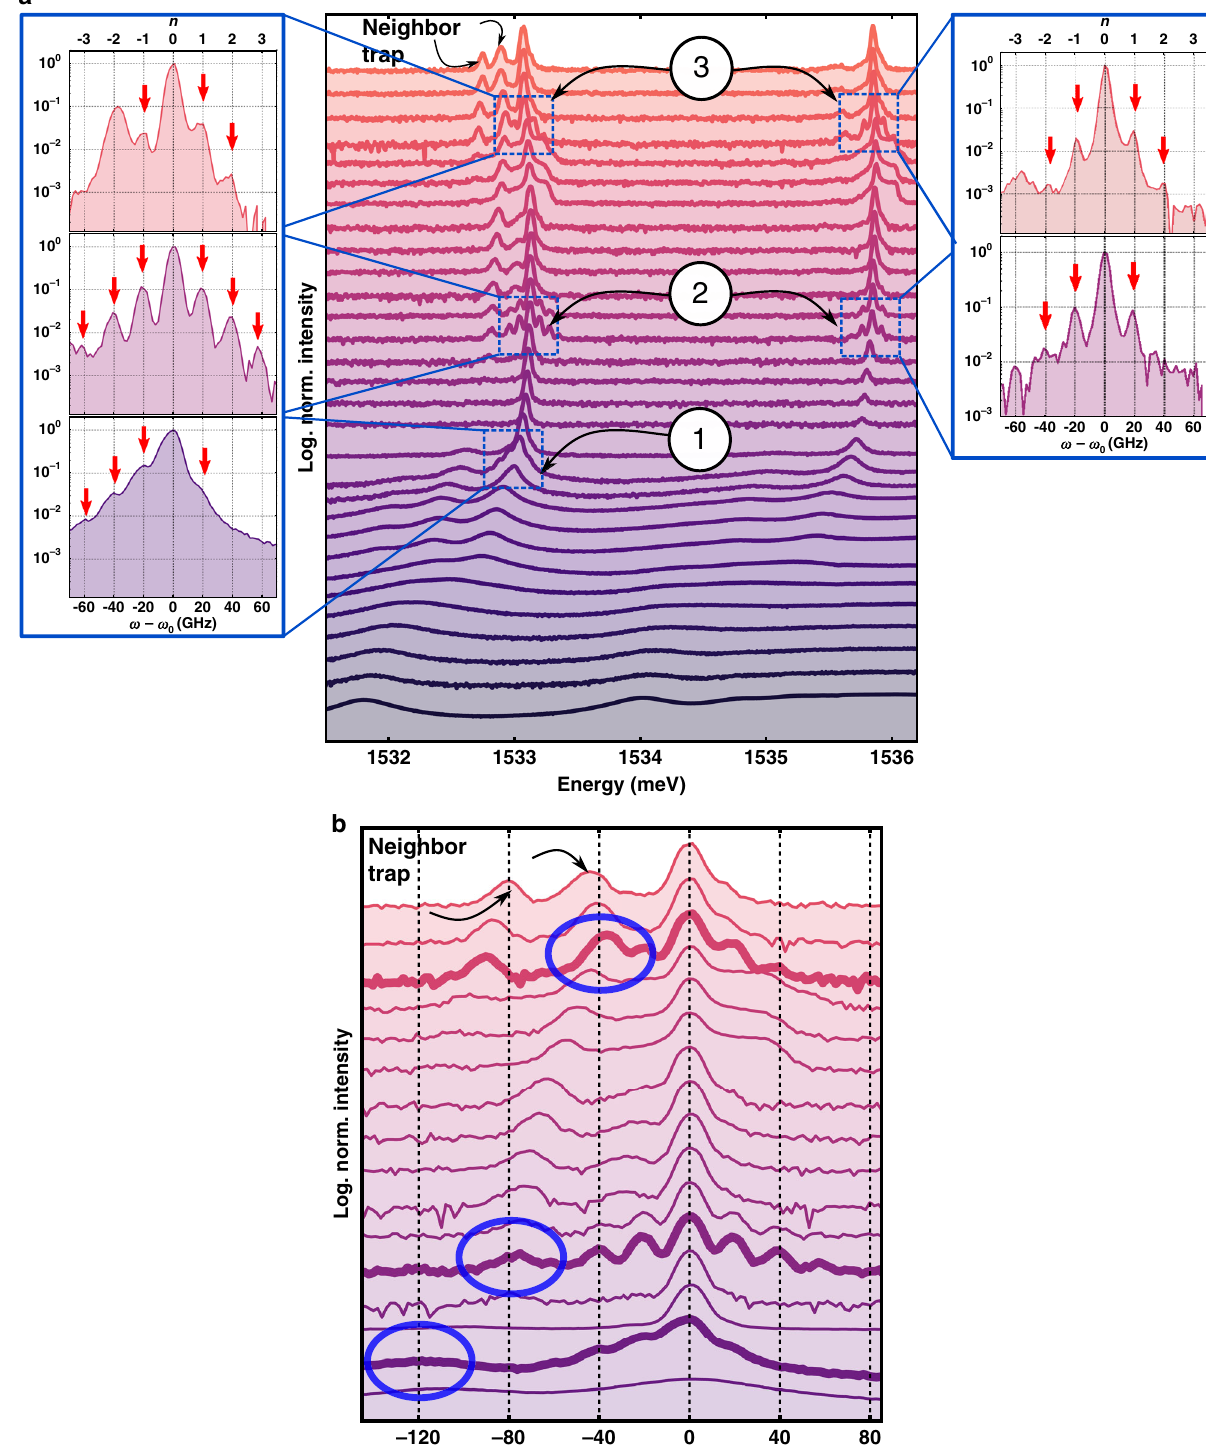
Fig. 3 Regenerative mechanical self-oscillation induced by a BEC. a PL spectra for varying cw nonresonant excitation powers, for a 1.6 μ m polariton square trap array. All spectra have been normalized to the maximum intensity. The numbered arrows highlight: (1) low-energy vibrational sidebands ¼ 20 GHz ~ 83 μ eV; (2) clearly resolved sidebands at both sides of the fundamental and fi rst excited polariton BEC states; and (3) spaced by ν 0 m reappearance of the sidebands at a high excitation power. The left and right insets show details of the fundamental BEC and fi rst excited polariton state, respectively. b PL spectra shifted in energy and shown relative to the fundamental BEC state, indicating PL contributions from neighbor traps. The spectra with pronounced sidebands (corresponding to the regions 1 – 3 in a ) are highlighted with thicker traces. For these spectra, the energy of a neighbor trap (cid:2) 20 (circular labels) is redshifted by an even multiple of the con fi ned mechanical mode ν 0 m